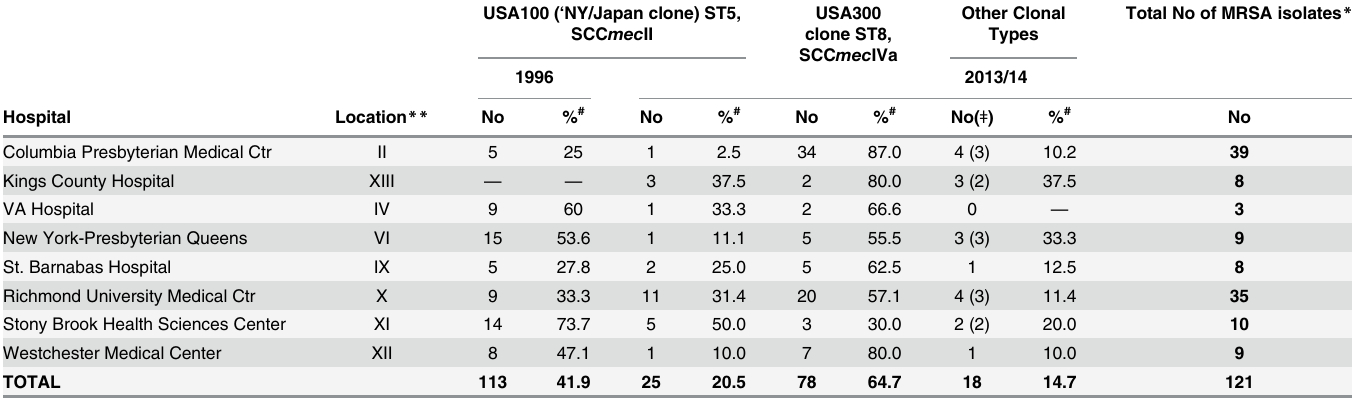
Table 4. Representation of MRSA clones USA100, USA300 and other clonal types in New York City area hospitals during the two surveillance periods.